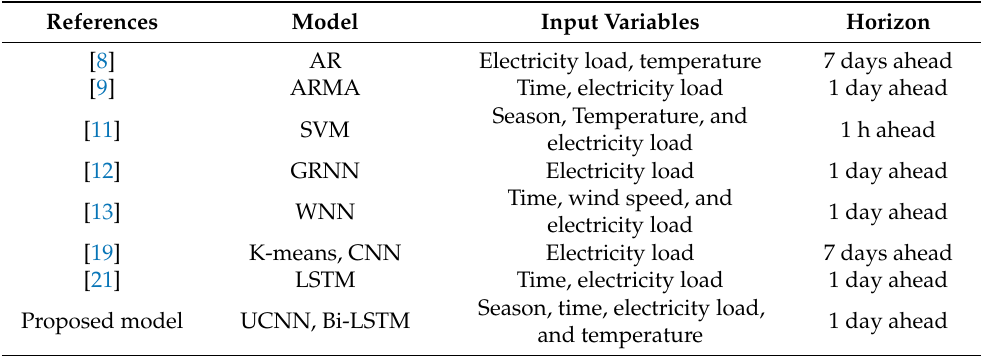
Table 1. Comparison of the proposed model with related papers in the